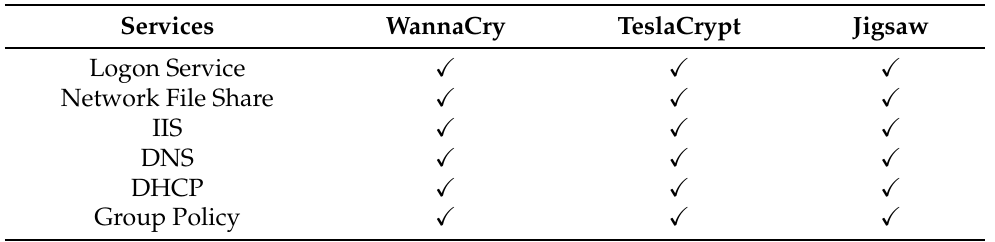
Table 2. Experimental results. As expected, all tested services were functional to a degree against all three ransomware variants. Services WannaCry TeslaCrypt